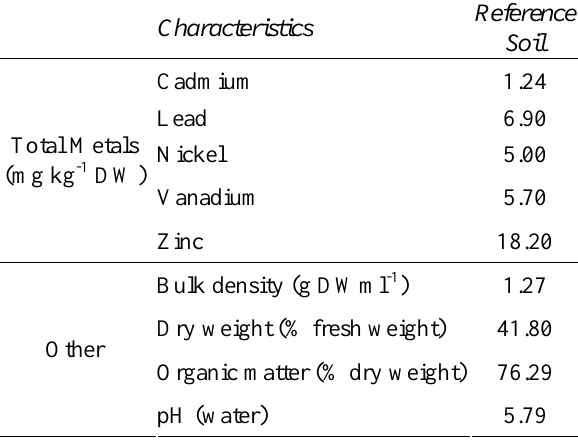
Table 1: Reference soil profile [7].